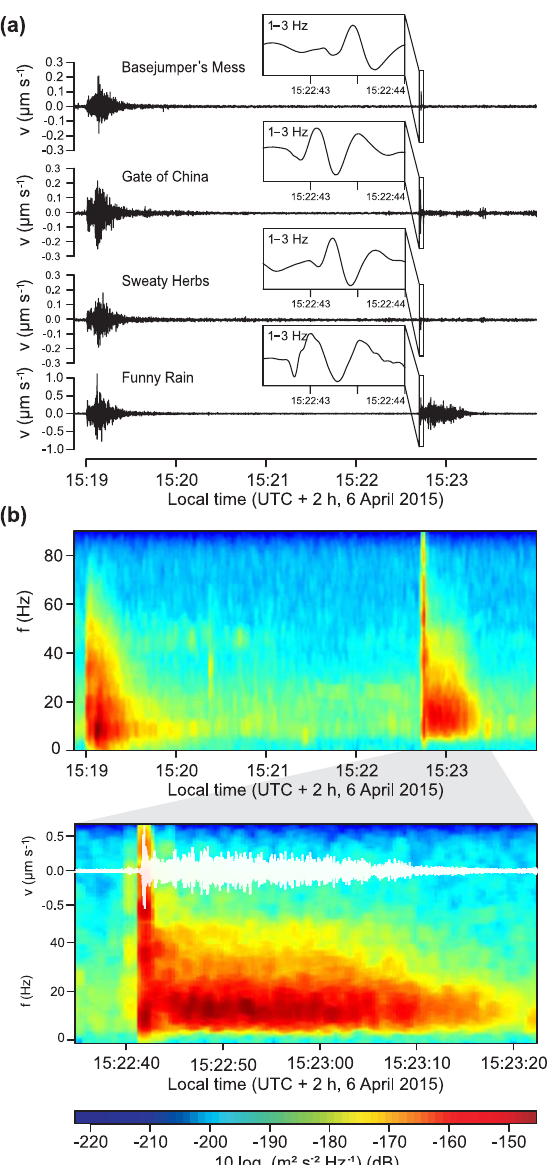
Figure 2. Seismic data of two detected seismic events. The first one shows the arrival of two pulses with sharp onsets homogeneously at all stations and a more than 1min coda. The second one shows very different signal properties across the seismic stations. (a) Waveform data (0.5–90Hz) starting with a small earthquake on 6 April 2015 at 15:19 that show the typical P- and S-wave arrivals and coda; 3.6min later, a rockfall (event 30) was detected, showing a very different, distinct waveform pattern. The inset shows low-pass-filtered (1– 3Hz) signals of the initial rock mass impact with clear time offset between the seismic stations. (b) Power spectral density estimates of the earthquake and rockfall as recorded by the vertical compo- nent of station Funny Rain. The zoomed part shows the waveform of the rockfall